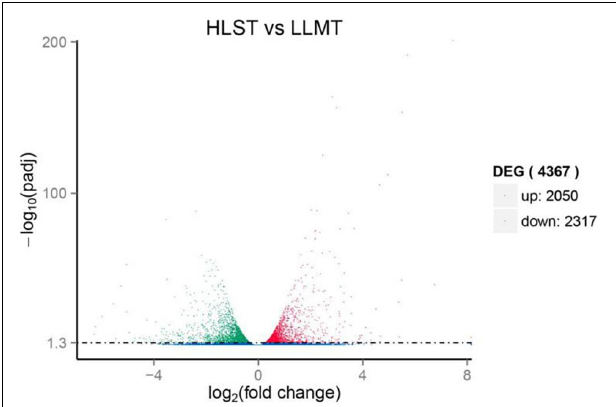
FIGURE 4 | Expression analysis of differentially expressed genes (DEGs). Y-axis represents statistical significance of DEGs. X-axis represents change fold of gene expression. Red and green dots represent upregulated genes and downregulated genes, respectively. Blue dots represent genes with no significant difference in expression